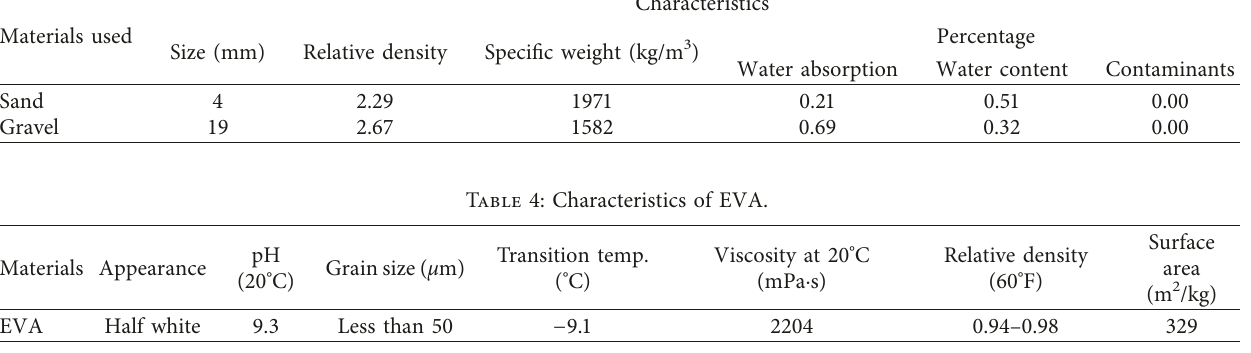
Table 5: Softening of EVA through the Vicat apparatus. Sample